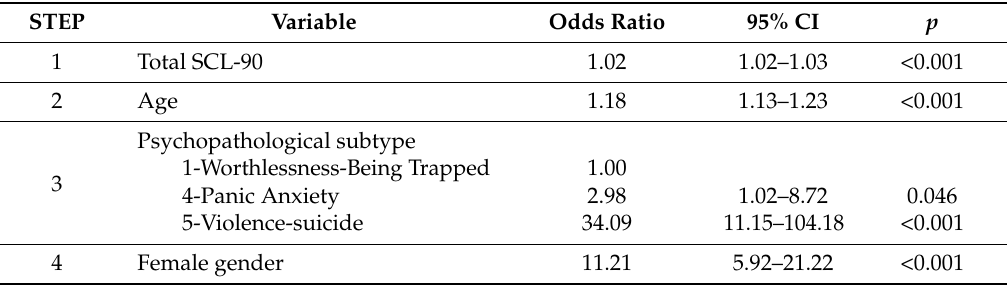
Table 3. Logistic regression analysis. Criterion: being in the obese group. Predictors: Psychopathological typology corrected for age, gender, and severity of symptomatology (only significant results are reported in the